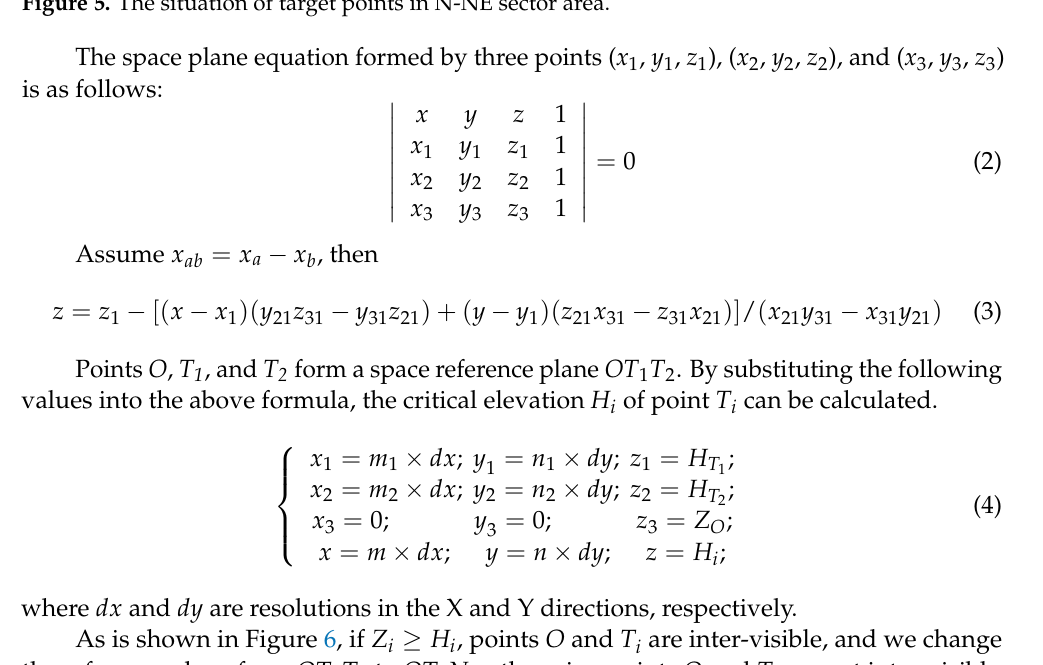
Figure 5. The situation of target points in N-NE sector area.